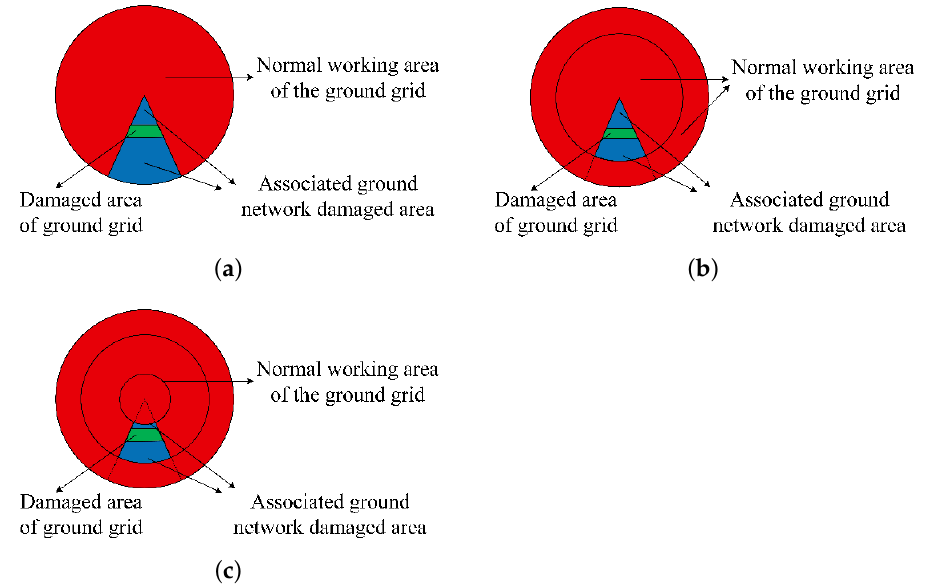
Figure 2. Schematic diagram of the different working conditions of the ground grid system. ( a ) In the absence of confluence rings; ( b ) after laying a few confluence rings; and ( c ) after lay- ing multiple